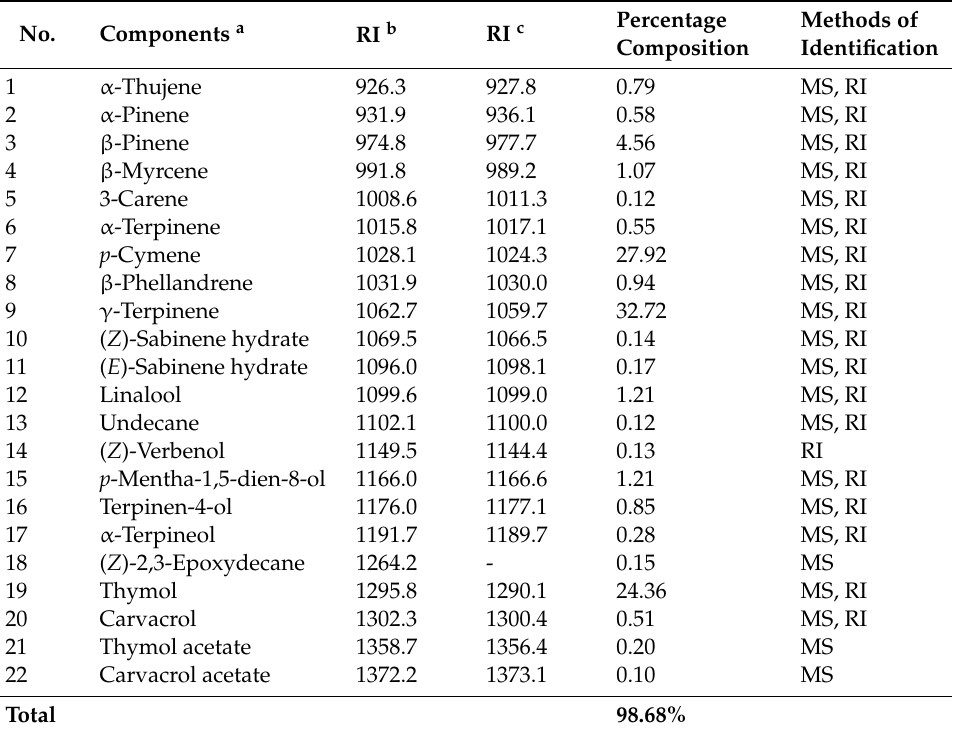
Table 1. Chemical composition of the essential oil derived from the fruits of T. ammi grown in